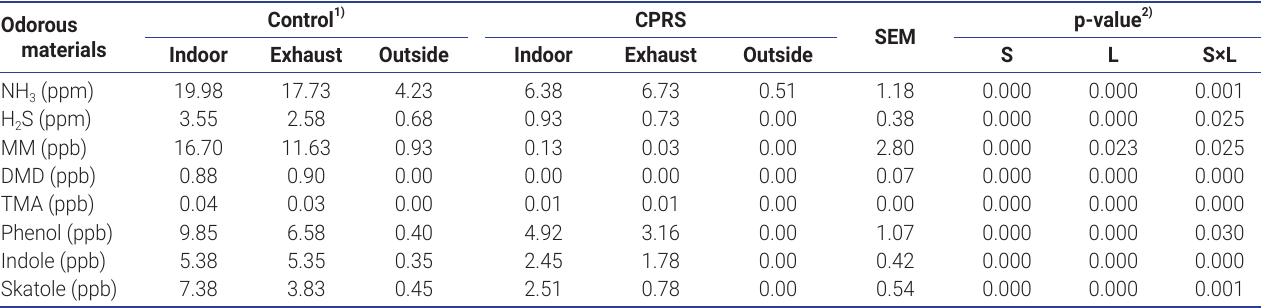
Table 5. Comparison of odorous material contents at various sampling points according to the application of continuous pit recirculation